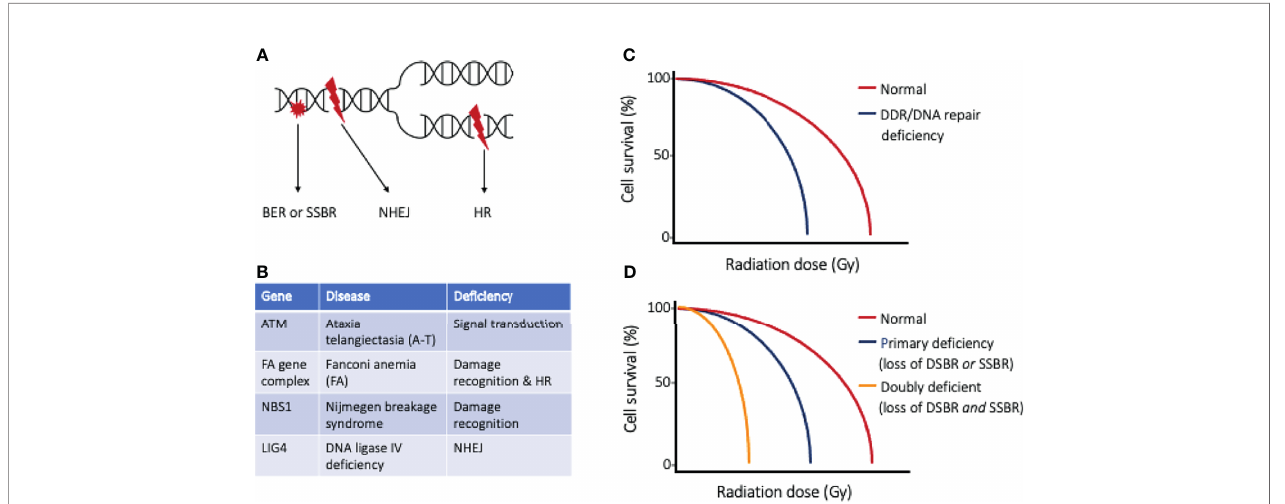
FIGURE 1 | The DNA damage response and DNA repair. (A) Ionizing radiation results in DNA base damage, single-strand breaks, and double-strand breaks that are repaired using base excision repair (BER), single-strand break repair (SSBR), or double-strand break repair (DSBR), respectively. The types of DSBR include non- homologous end-joining (NHEJ), which can occur through all phases of the cell cycle, or homologous recombination (HR), which requires cells to have completed synthesis phase. (B) Table of DNA repair disorders (gene de fi ciencies) that are associated with clinical radiation sensitivity, and (C) cell survival curves of normal cells and cells with such DDR/DNA repair de fi ciency. Cells with defective DDR/DNA repair pathways are more sensitive to radiation injury, as exempli fi ed by a narrow shoulder region of the survival curve and lower radiation dose to achieve lethality. (D) Cell survival curves highlighting the effect of targeted strategies directed at inhibiting the “ back-up ” repair pathway. An example of doubly de fi cient cells could be BRCA1/2 de fi cient tumor cells (loss of DSBR) and selective PARP inhibition (loss of